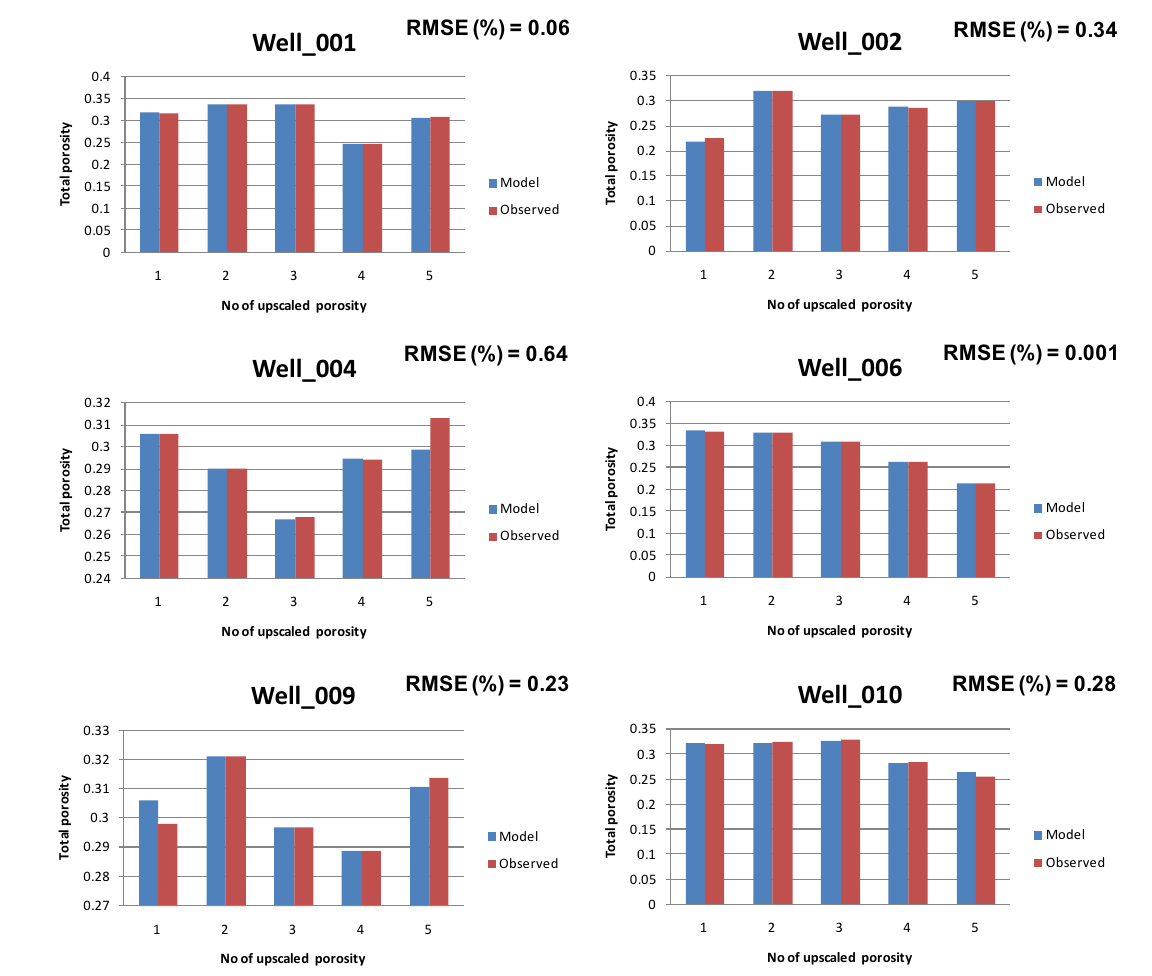
Fig. 16 Sample of total porosity derived from well logs compared with estimated total porosity from model at well bore